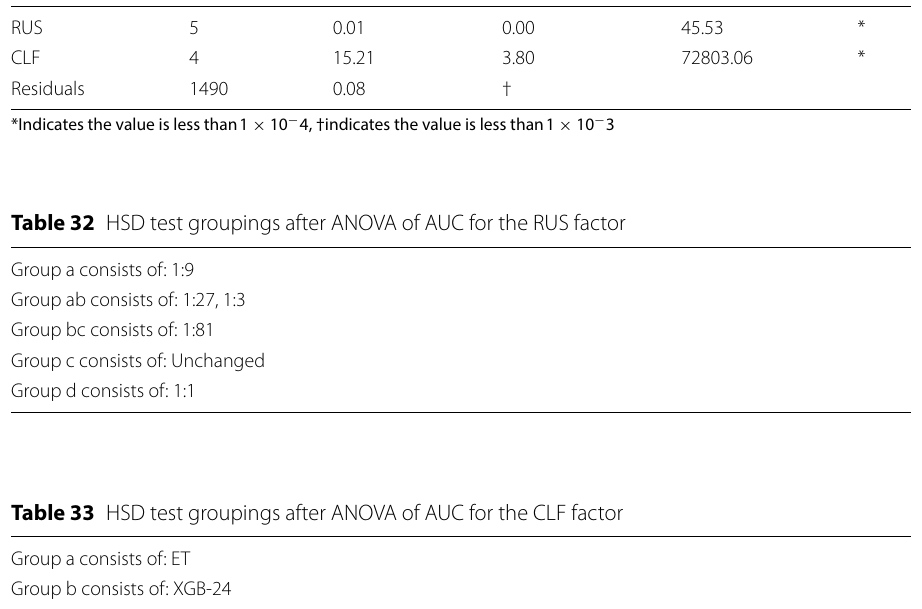
Table 31 ANOVA for RUS and CLF as factors of performance in terms of AUC Df